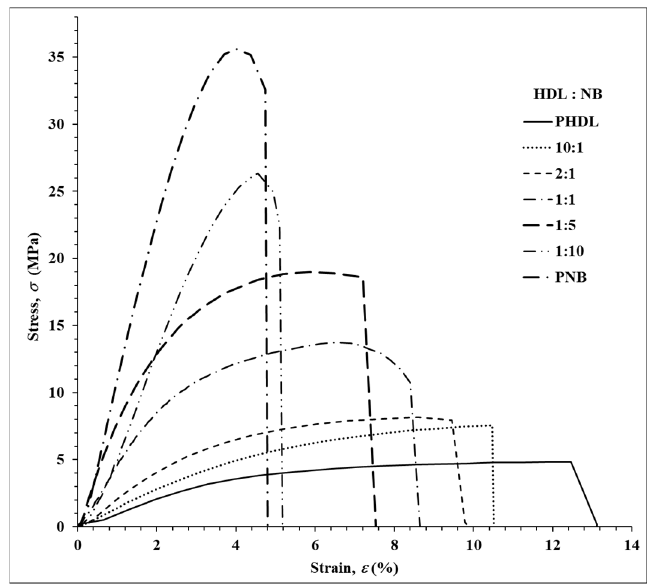
Figure 4. Strain–stress curves of pure PNB, PHDL, and HDL-NB copolymers with several molar ratios [HDL]/[NB]. ratios